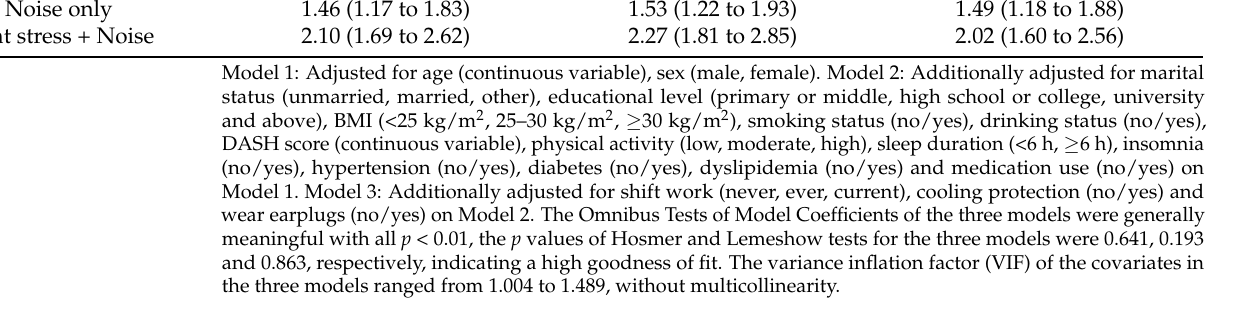
Table 3. Multivariate adjusted ORs between carotid plaque and different exposure status by sex, BMI and shift